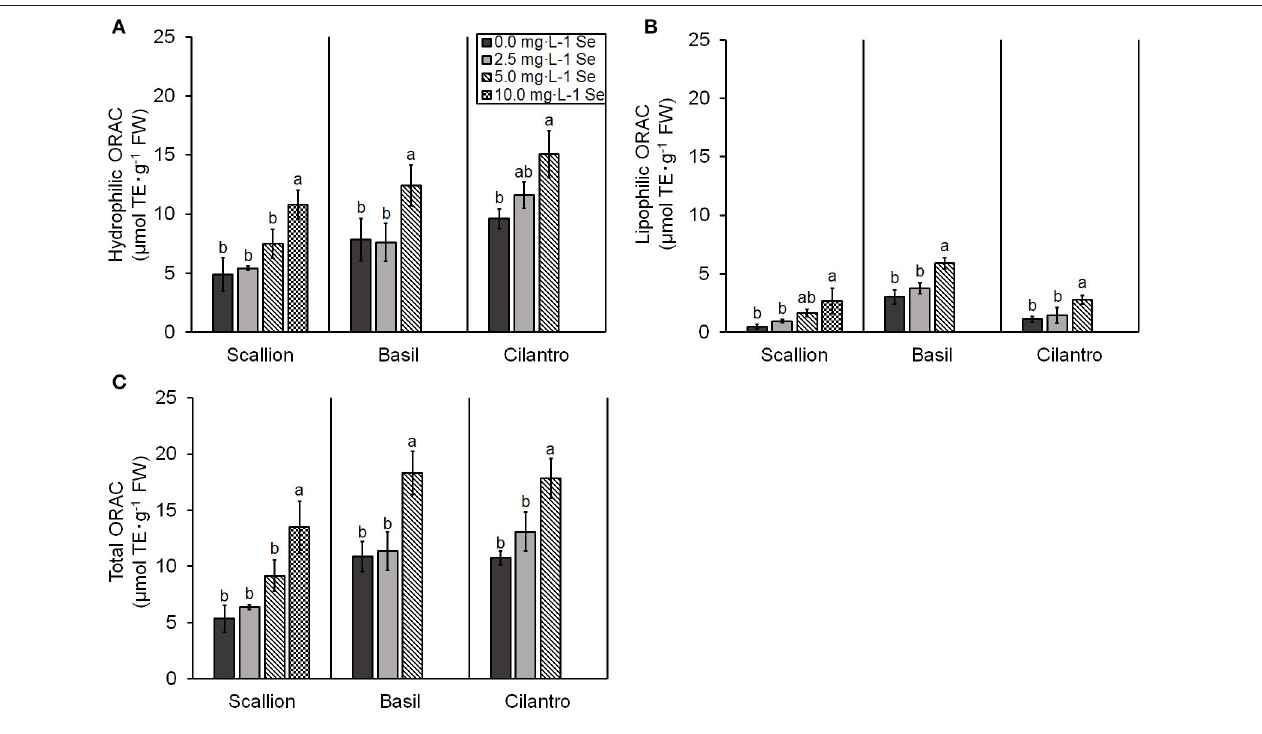
FIGURE 5 | (A) Hydrophilic, (B) lipophilic, and (C) total oxygen radical absorbance capacity (ORAC) values for scallion ( Allium fistulosum L.), basil ( Ocimum basilicum L.), and cilantro ( Coriandrum sativum L.) microgreens treated with various concentrations of selenium (Se) as sodium selenate on a fresh weight (FW) basis. Bars indicate mean ± standard deviation (SD) for three replicates ( n = 3) of each plant species. The Tukey’s significance at P ≤ 0.05 among Se treatments is indicated by different letters within the plant species.